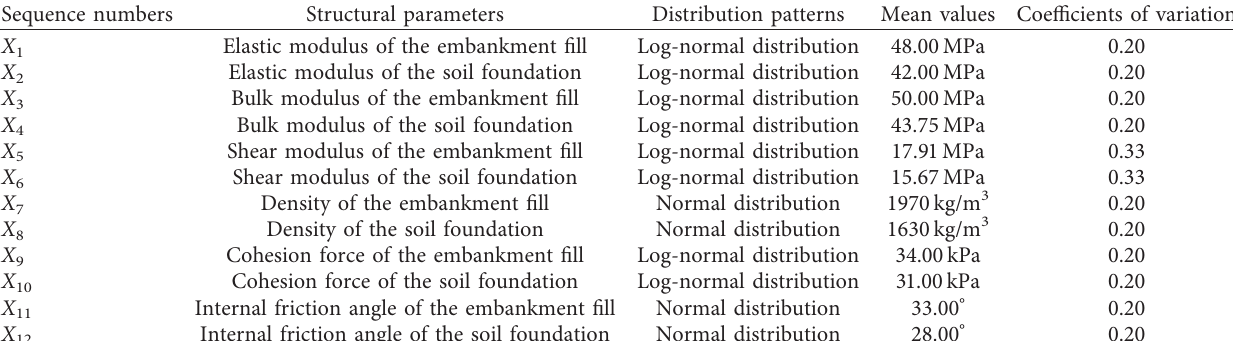
Table 1: Probability distribution parameters of the structural